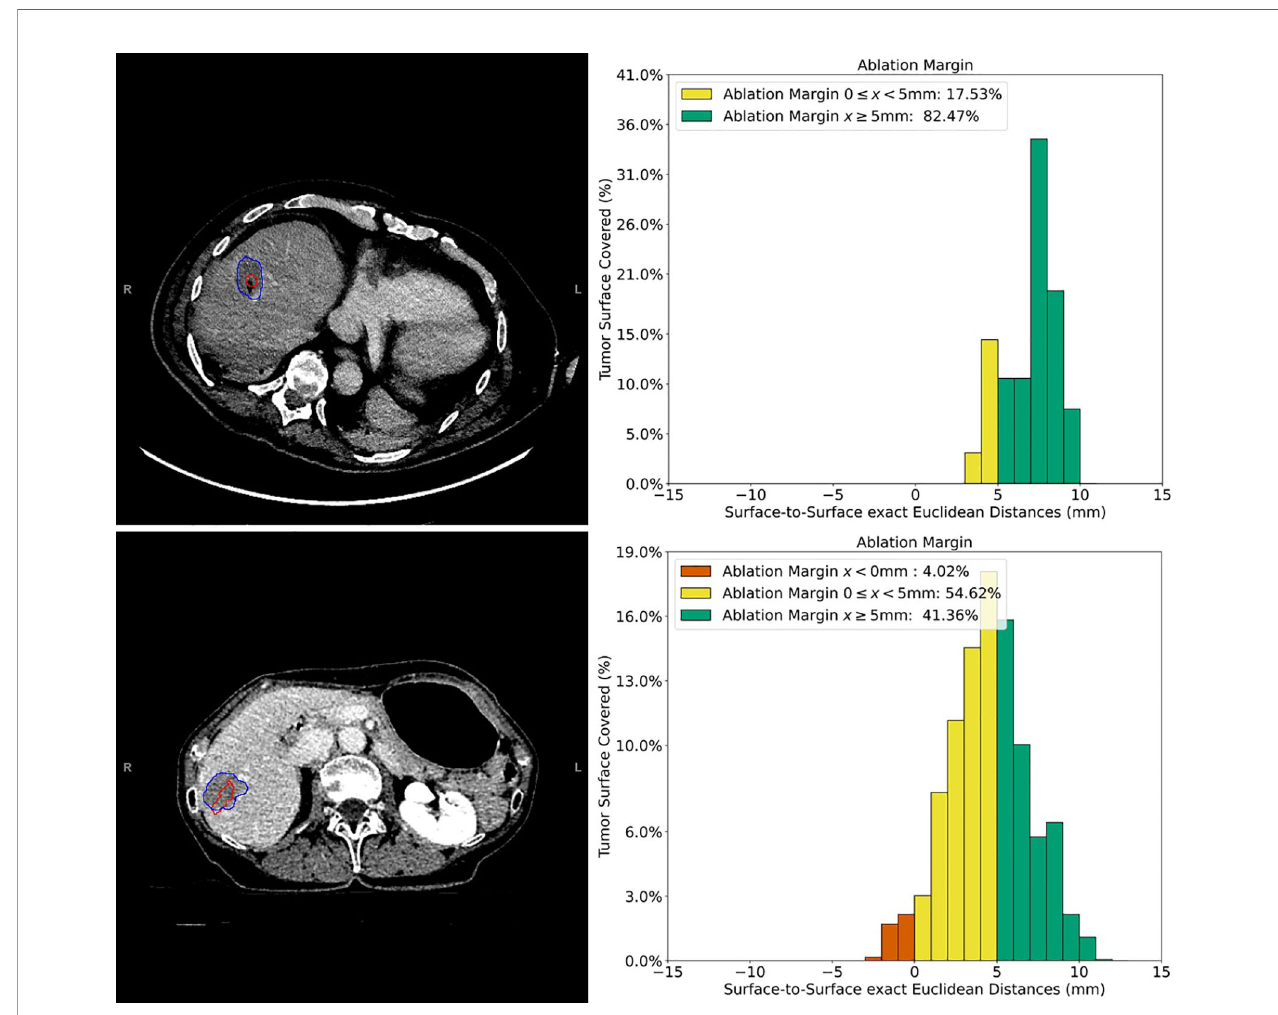
FIGURE 3 | Example cases of three-dimensional quantitative ablation margin (3D-QAM) assessment in patients with colorectal liver metastases (CRLMs). Upper images: contrast-enhanced CT image of a CRLM in segment 8 treated with stereotactic microwave ablation (SMWA), with corresponding histogram of 3D-QAM on the right. Lower images: contrast-enhanced CT image of CRLM in segment 7 and its corresponding histogram of 3D-QAM distribution on the right. Segmentations of the tumor in both CT scans are marked in red, and the corresponding ablation volumes are marked in blue. Relative distribution of ablation margins with respect to percentage of tumor surface covered is displayed as a histogram, colored green for margins >5 mm, yellow for margins 0 – 5 mm, and red for residual tumor (margins <0